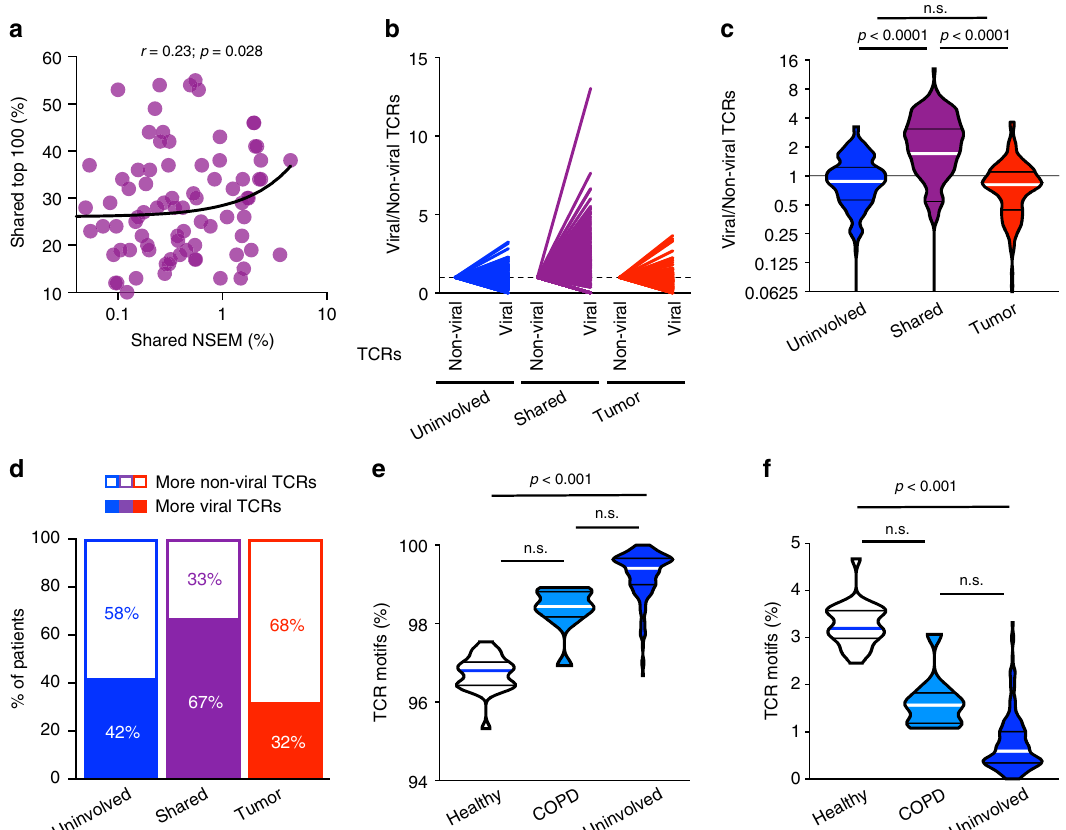
Fig. 8 Shared T cells may target shared mutations and viruses. a Correlation between the proportion of shared mutations (NSEM) and shared top 100 T cells between the uninvolved tumor-adjacent lung and tumor ( n = 92). b – c Fold difference between non-viral and viral T cell motifs found exclusively in the tumor-adjacent uninvolved lung (blue), tumor (red), or shared ( n = 178). d Proportion of patients with viral (solid) or non-viral (white) motifs enriched in the uninvolved tumor-adjacent lung (blue), tumor (red), or shared T cells (purple) ( n = 178). e Proportion of non-viral ( n = 215) and ( f ) viral motifs ( n = 215) in healthy, COPD, or tumor-adjacent uninvolved lungs. Bars represent median and